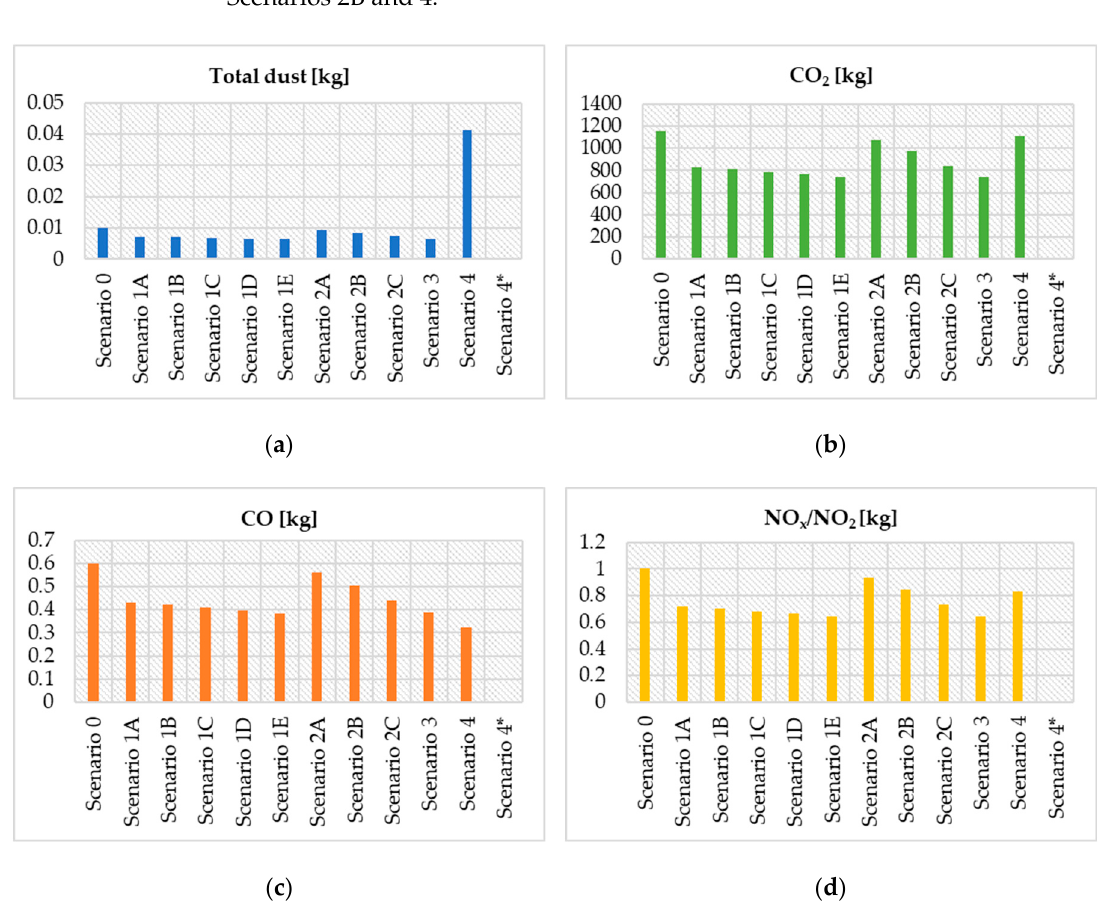
Figure 5. Ecological analysis of the scenarios adopted: ( a ) total dust emission; ( b ) carbon dioxide emission; ( c ) carbon monoxide emission; ( d ) nitrogen oxide